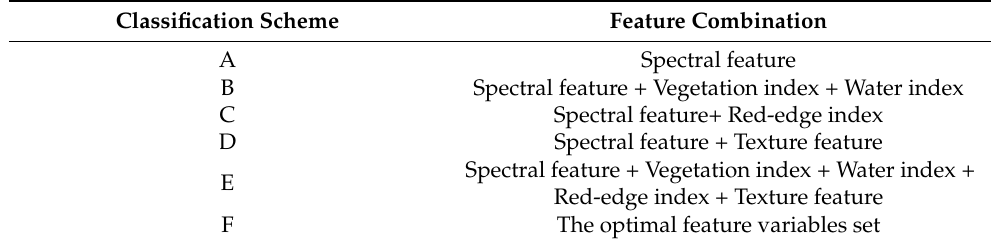
Table 5. Descriptions of the classification